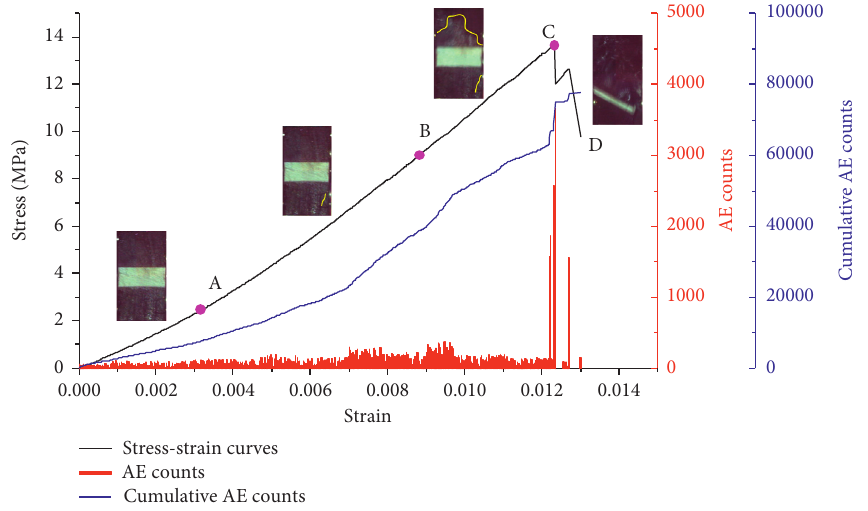
Figure 10: Stress-strain curve and acoustic emission monitoring curve of 20mm-thick composite specimens (B20-1).